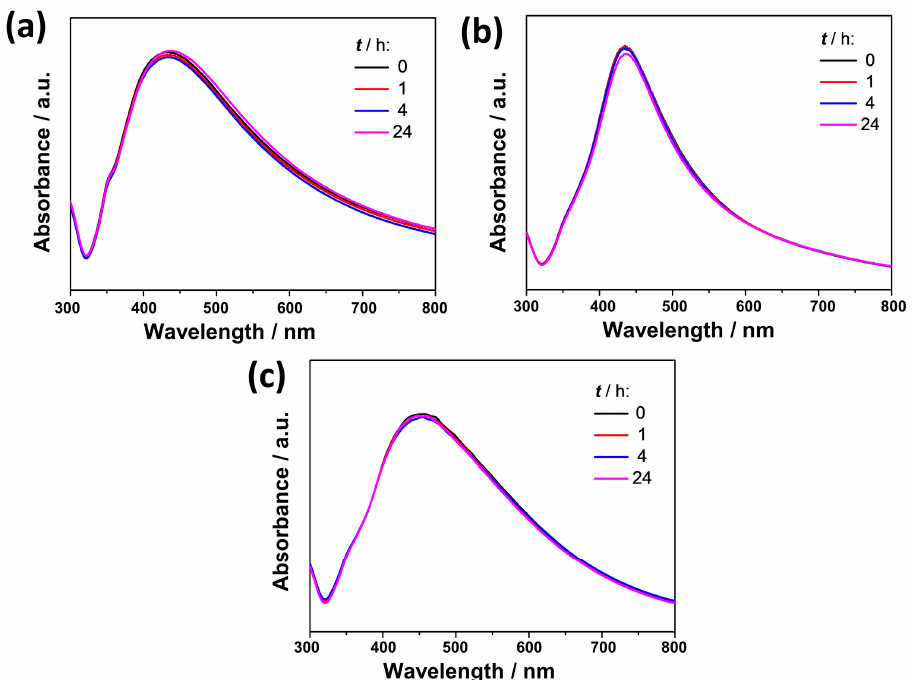
Figure 2. UV-Vis spectra of silver nanoparticles (AgNPs), stabilized with ( a ) citrate (cit-AgNPs), ( b ) poly(vinylpyrrolidone) (PVP-AgNPs), and ( c ) sodium bis(2-ethylhexyl) sulfosuccinate (AOT- AgNPs). ( γ (AgNPs) = 50 mg dm − 3 ) in UPW at 25 ◦ C recorded at different time periods.